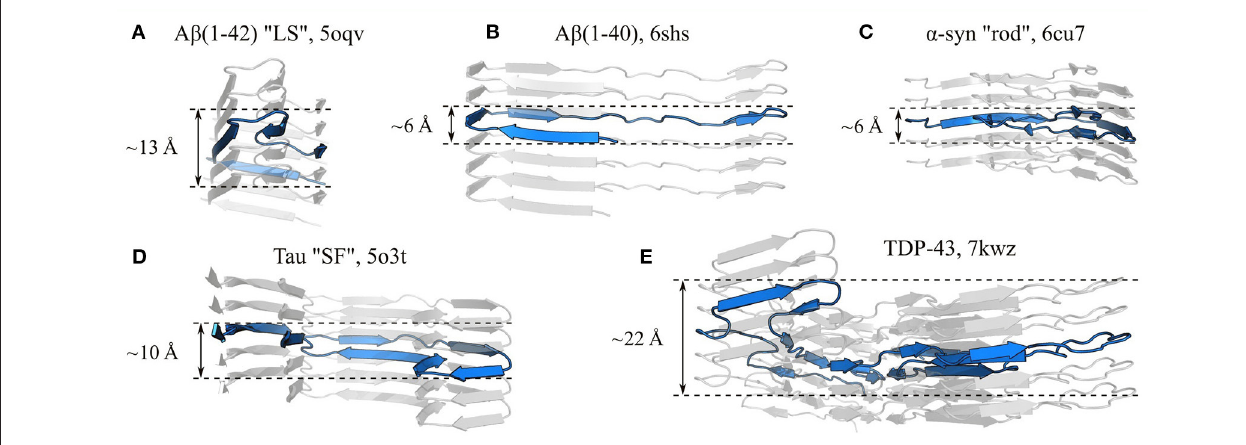
FIGURE 8 | The subunits of amyloid fibrils often occupy a single layer of the protofilament stack, but are not truly planar. Panels show side-on views of single protofilaments from fibrils formed by (A) A β (1-42) “LS” polymorph ( Gremer et al., 2017), (B) A β (1–40) (Kollmer et al., 2019), (C) α -syn “rod” polymorph (Li et al., 2018a), (D) Tau “SF” polymorph (Fitzpatrick et al., 2017), and (E) TDP-43 (Li et al., 2021), with a single subunit highlighted in blue in each case. The name of the polypeptide is given above each structure, alongside the polymorph in quotes where relevant, and the PDB ID. Measurements show the approximate subunit height variation along the protofilament axis. All panels use the same